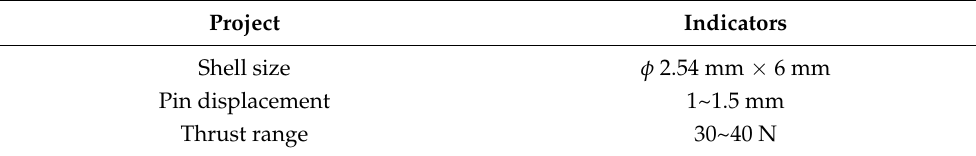
Figure 21. Pin pusher.